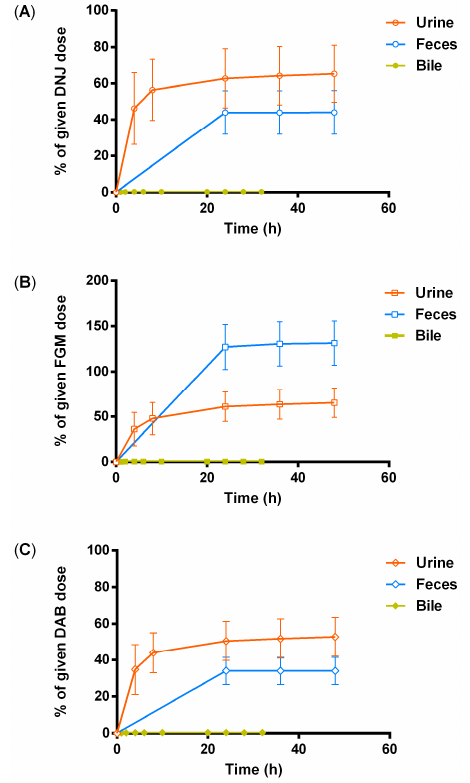
Figure 5. Cumulative excretion percentage of DNJ ( A ), FGM ( B ), and DAB ( C ) in urine, feces, and bile after an oral administration of SZ–A at 40 mg/kg in rats ( n =